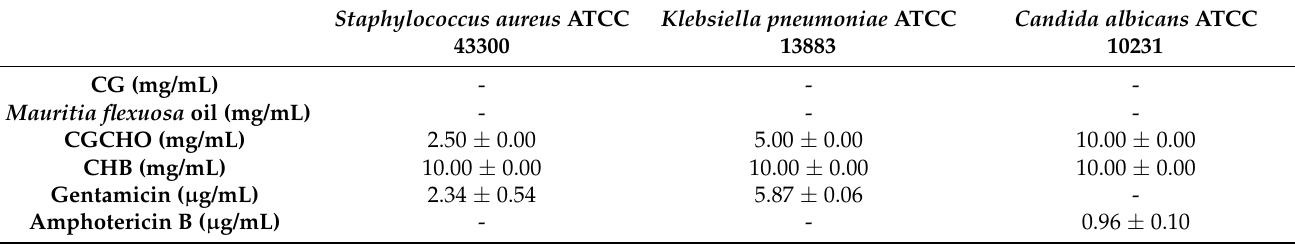
Table 1. Minimum inhibitory concentration (mic) for CG, Mauritia flexuosa oil, CGCHO and CHB against S. aureus , K. pneumoniae and C. albicans. Staphylococcus aureus ATCC Klebsiella pneumoniae ATCC Candida albicans ATCC 43300 13883